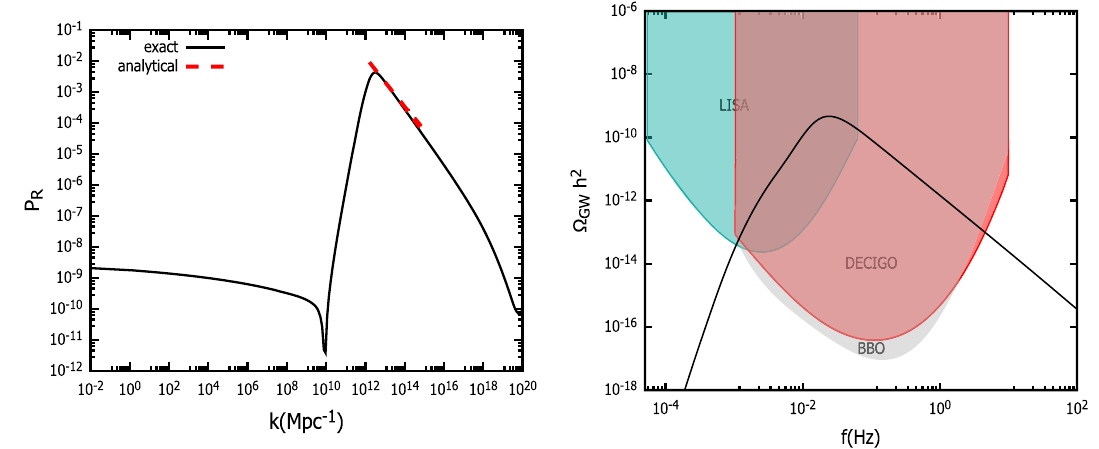
Fig. 4 The power spectrum (left) with solid line (numerical) and with dashed (analytical from Eq. 2.34). The density of stochastic GW (right). Both plots are for the case of modifying Cecotti superpotential. We choose c 3 = 13 . 2, l = 1 . 00028 and b 2 = 8 . 575